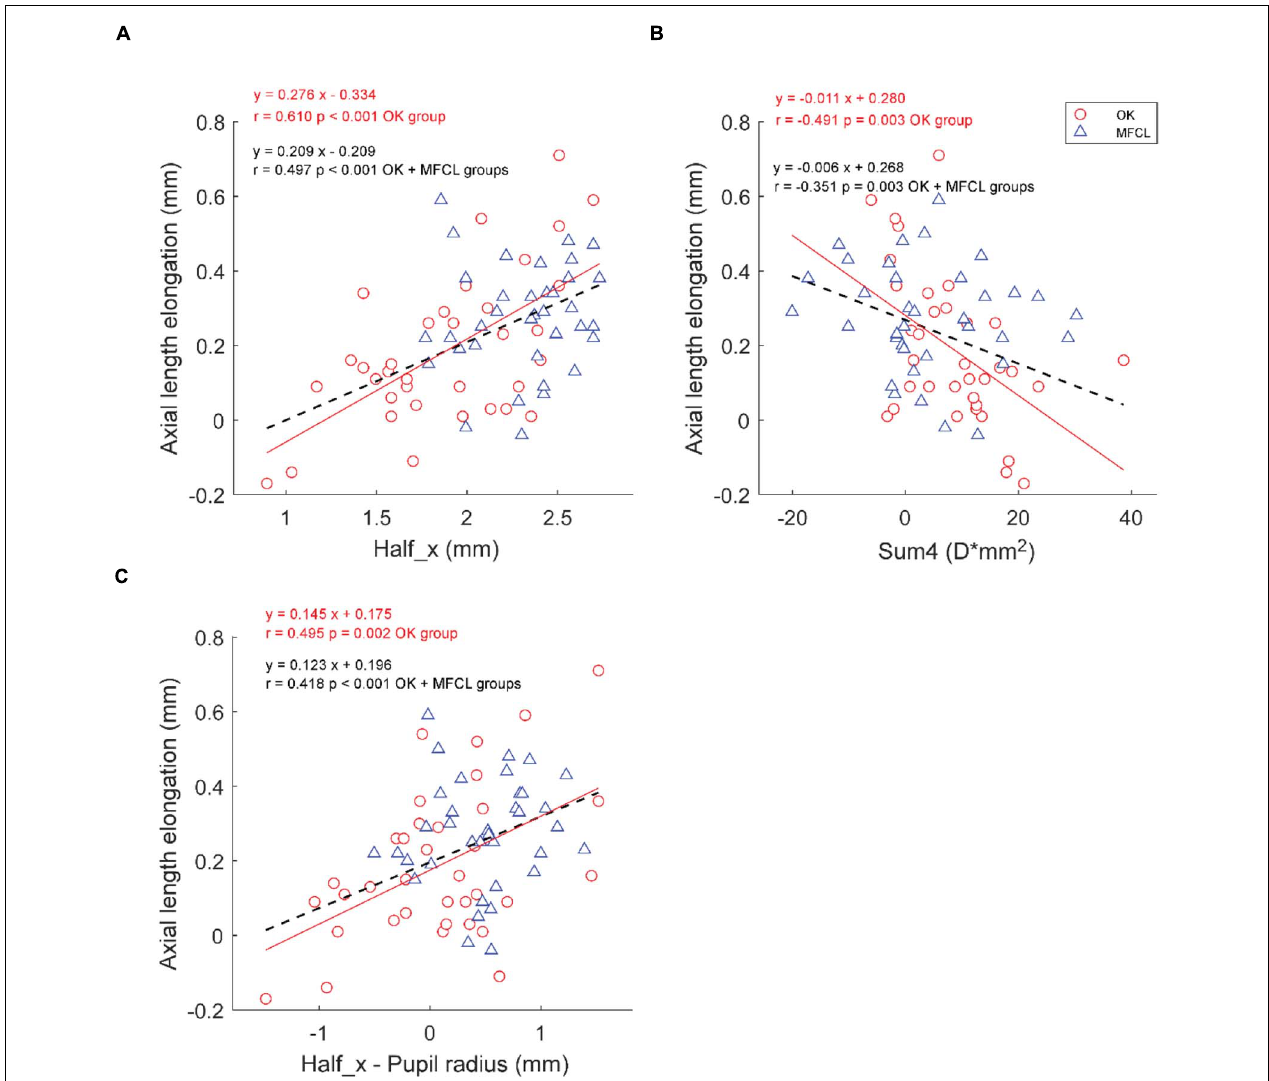
FIGURE 4 | Association between axial length elongation and RCRPS parameters (A) Half_x, (B) Sum4, (C) Half_x – Pupil radius for the OK group (red circles) and the MFCL group (blue triangles). The red solid line is the regression line of the OK data; the black dashed line is the regression line of the combined data. RCRPS, relative corneal refractive power shift; D, diopter; OK, orthokeratology; MFCL, multifocal soft contact lens; combined data: OK and MFCL; Half_x, the corneal eccentric location where RCRPS reached the half peak value; Sum4, the integrated value of the RCRPS located within an area of 4-mm